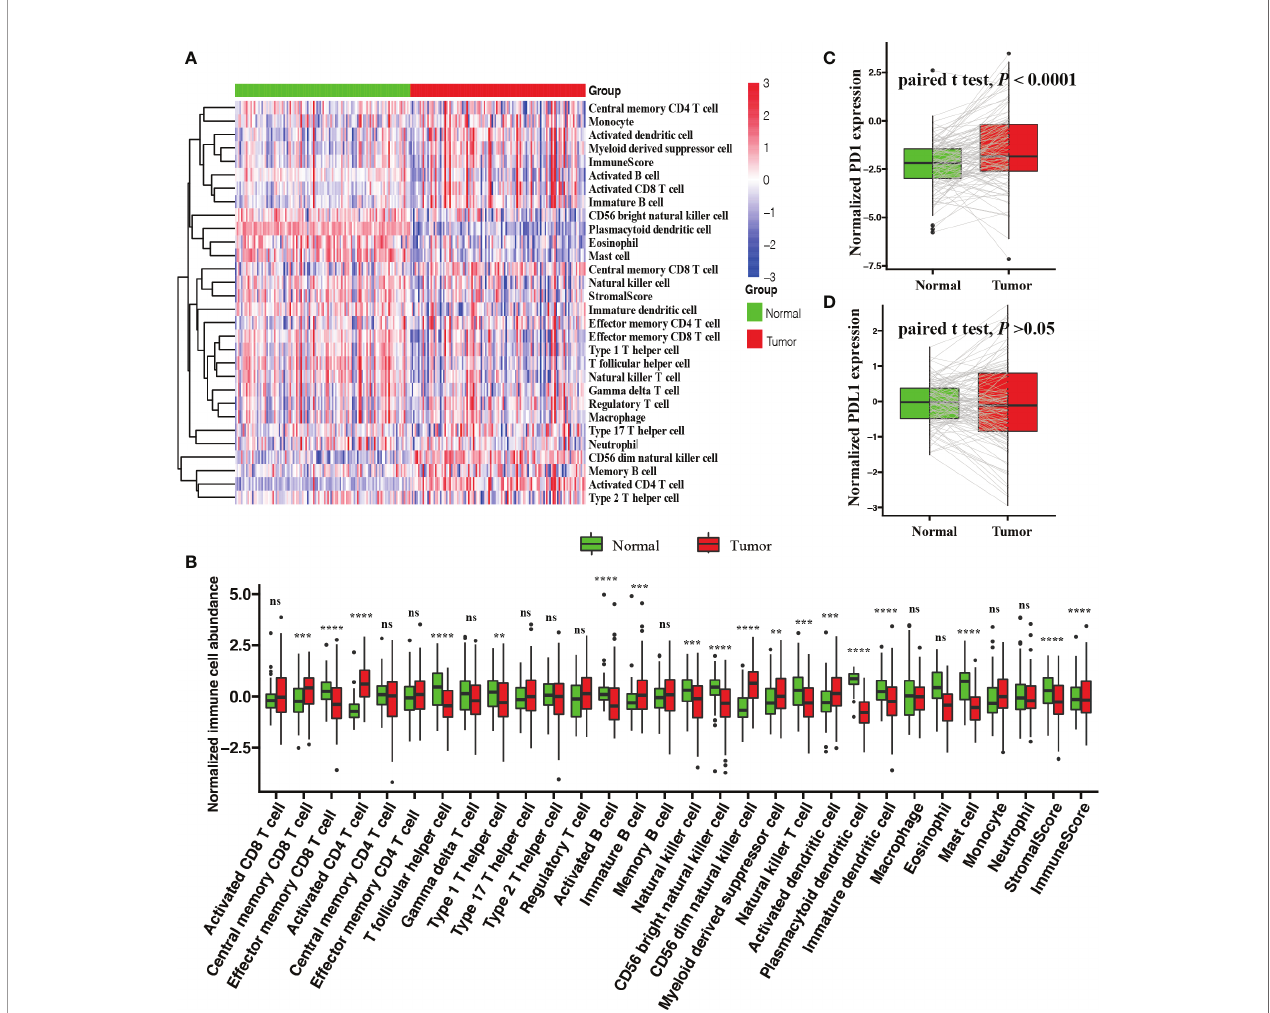
FIGURE 1 | Comparison of the TME between tumor and normal tissues with BRCA. (A) Heatmap of the ICI landscape between tumor and normal tissues. (B) Box plot of normalized immune cell abundances (Kruskal – Wallis test, ns, no signi fi cance P > 0.05; ** P < 0.01; *** P < 0.001; **** P < 0.0001). Comparison of the expression levels of two vital immune checkpoint molecules; (C) PD-1 and (D) PD-L1 (paired Student ’ s t